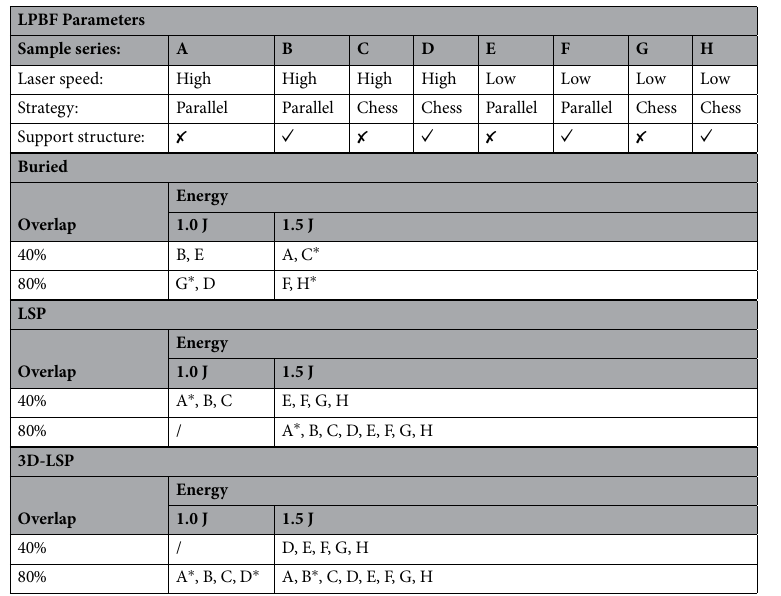
Table 1. Sample labels corresponding to the different LPBF parameter combinations, and the listing of the sample measured for each LSP